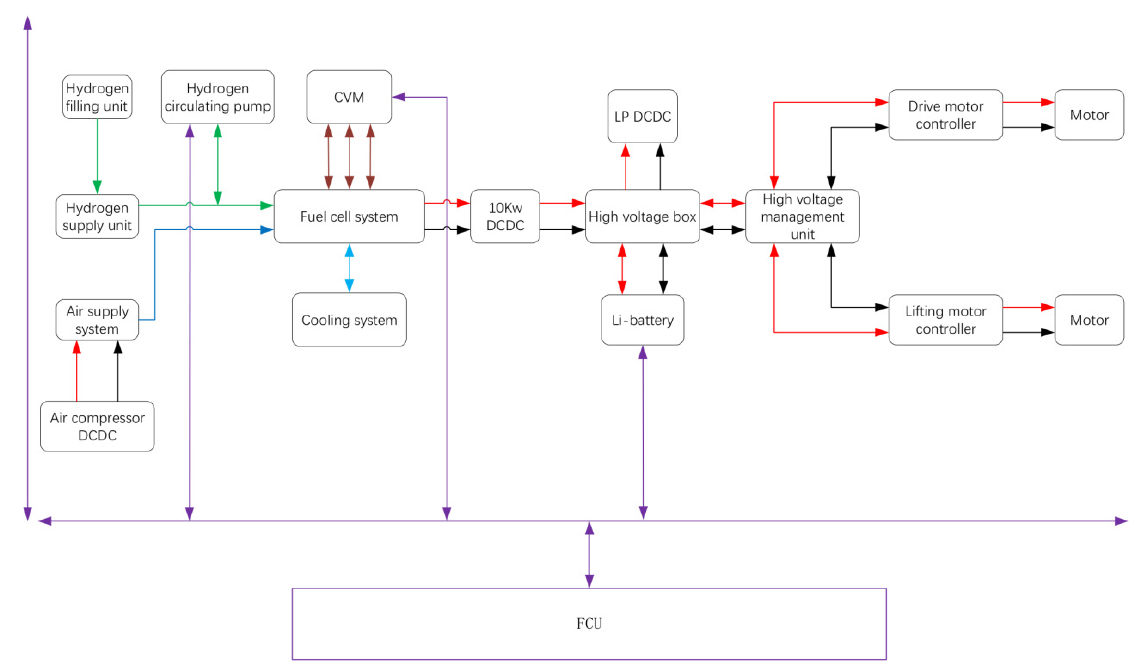
Figure 3. Overview of PEMFC hybrid drive system.